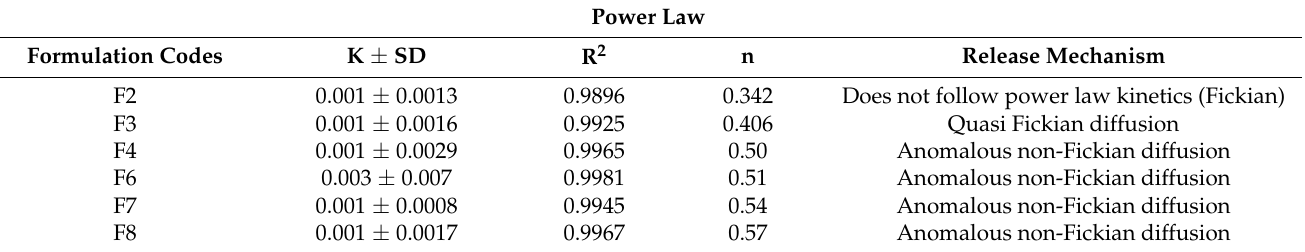
Table 9. Release kinetics of metronidazole floating effervescent tablets at 50 rpm.